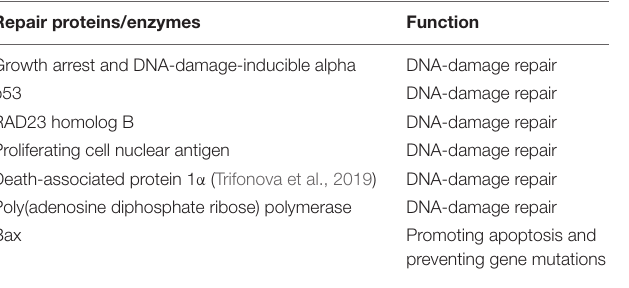
TABLE 1 | Vitamin D and gene-mutation repair (Fedirko et al., 2009; Fleet et al., 2012; De Rubeis et al., 2014). Repair proteins/enzymes